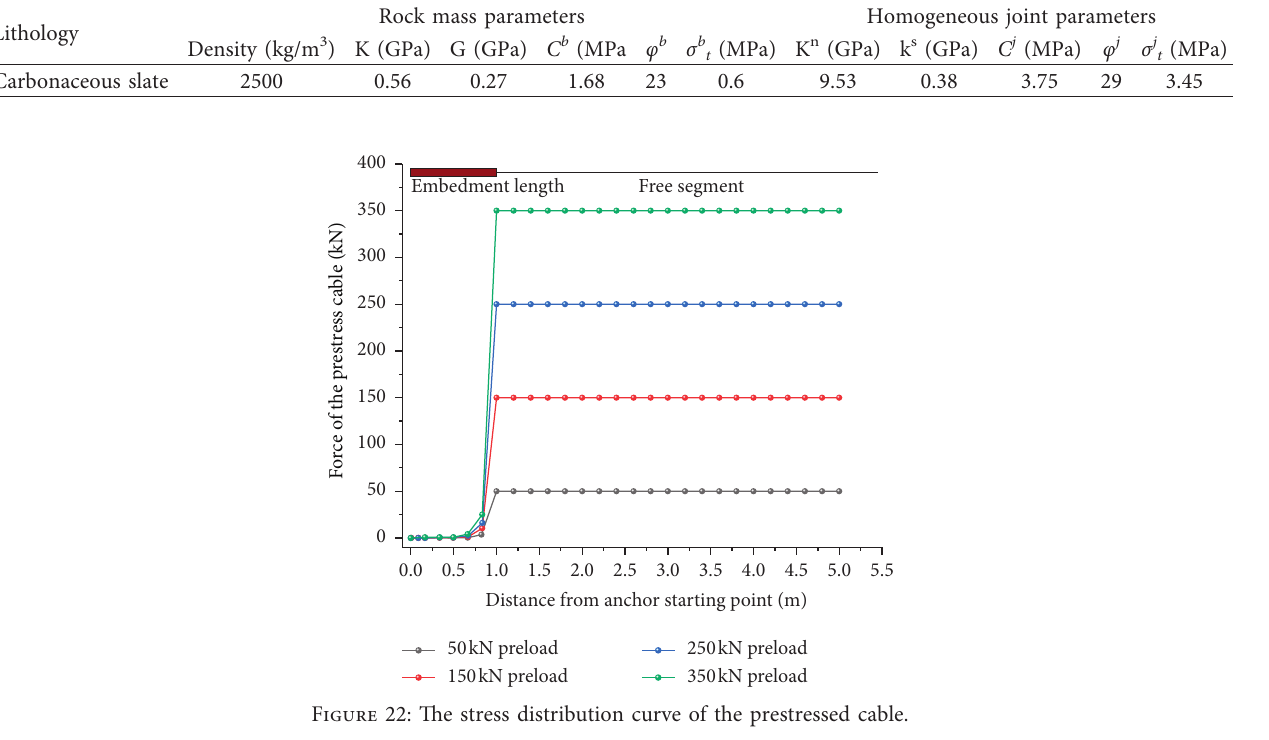
Table 2: . Mechanical parameters of carbonaceous slate.